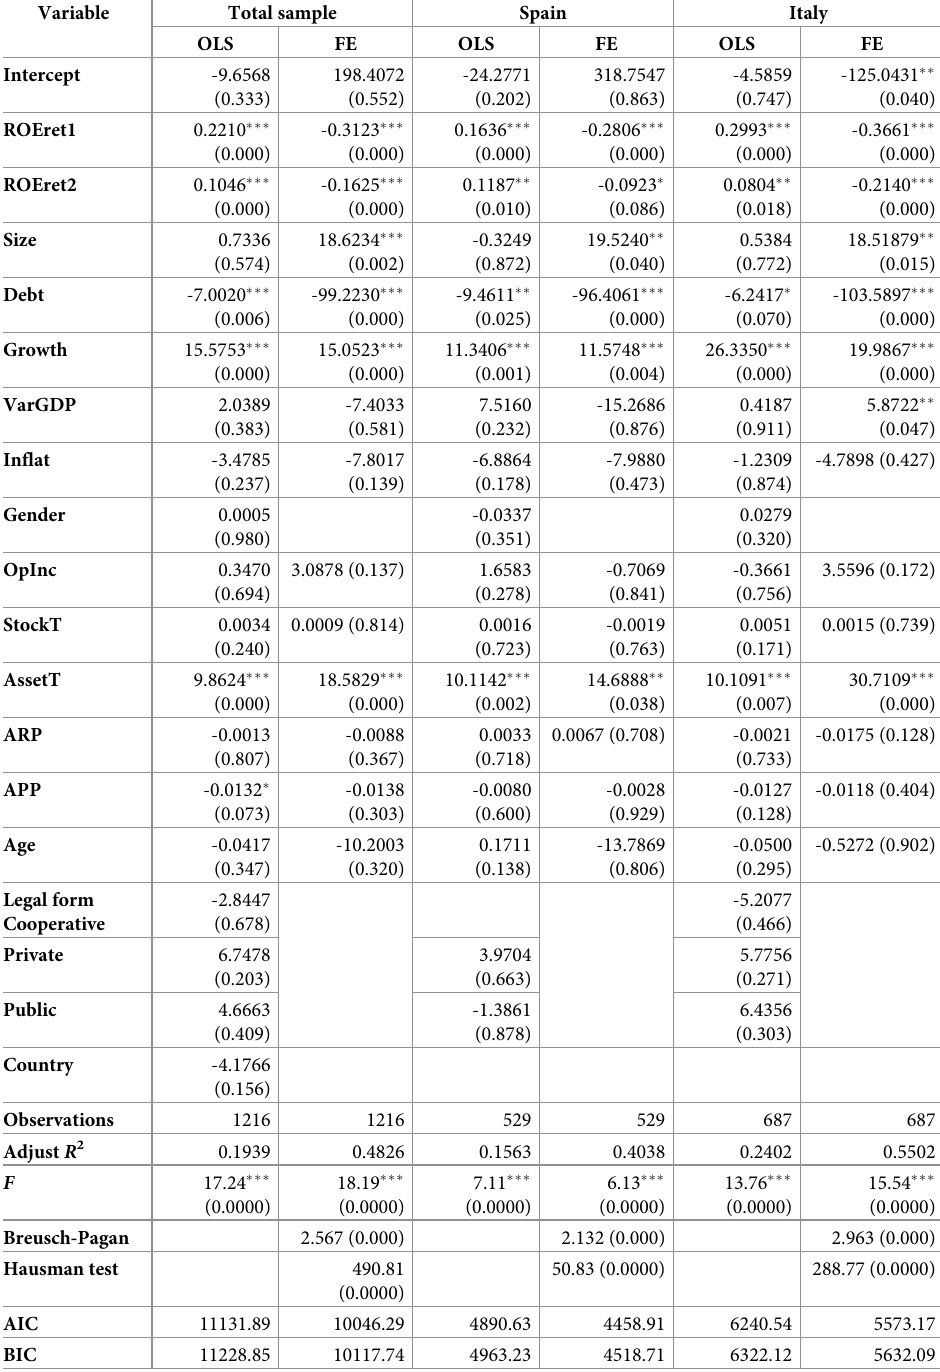
Table 6. ROE regression